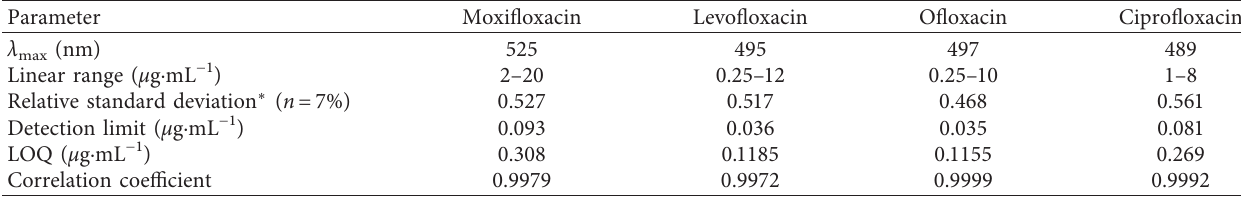
Table 1: The analytical performance of the method.